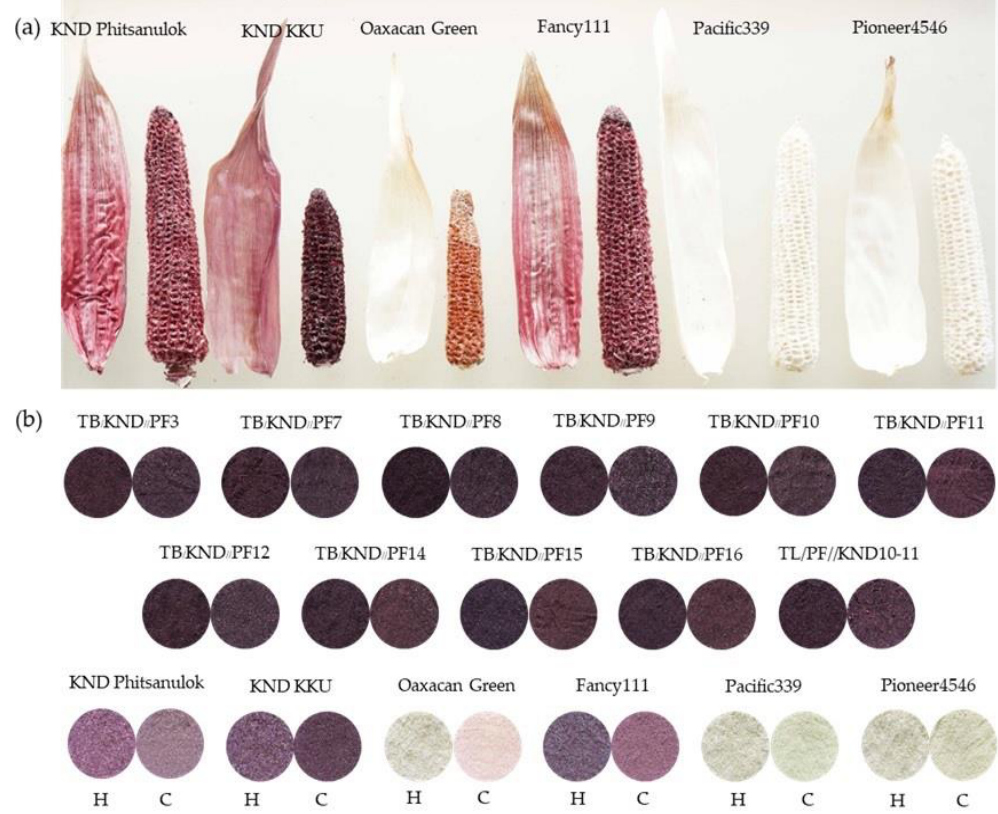
Figure 2. Husk (H) and cob (C) of ( a ) check varieties and ( b ) powdered samples of group A and check varieties.